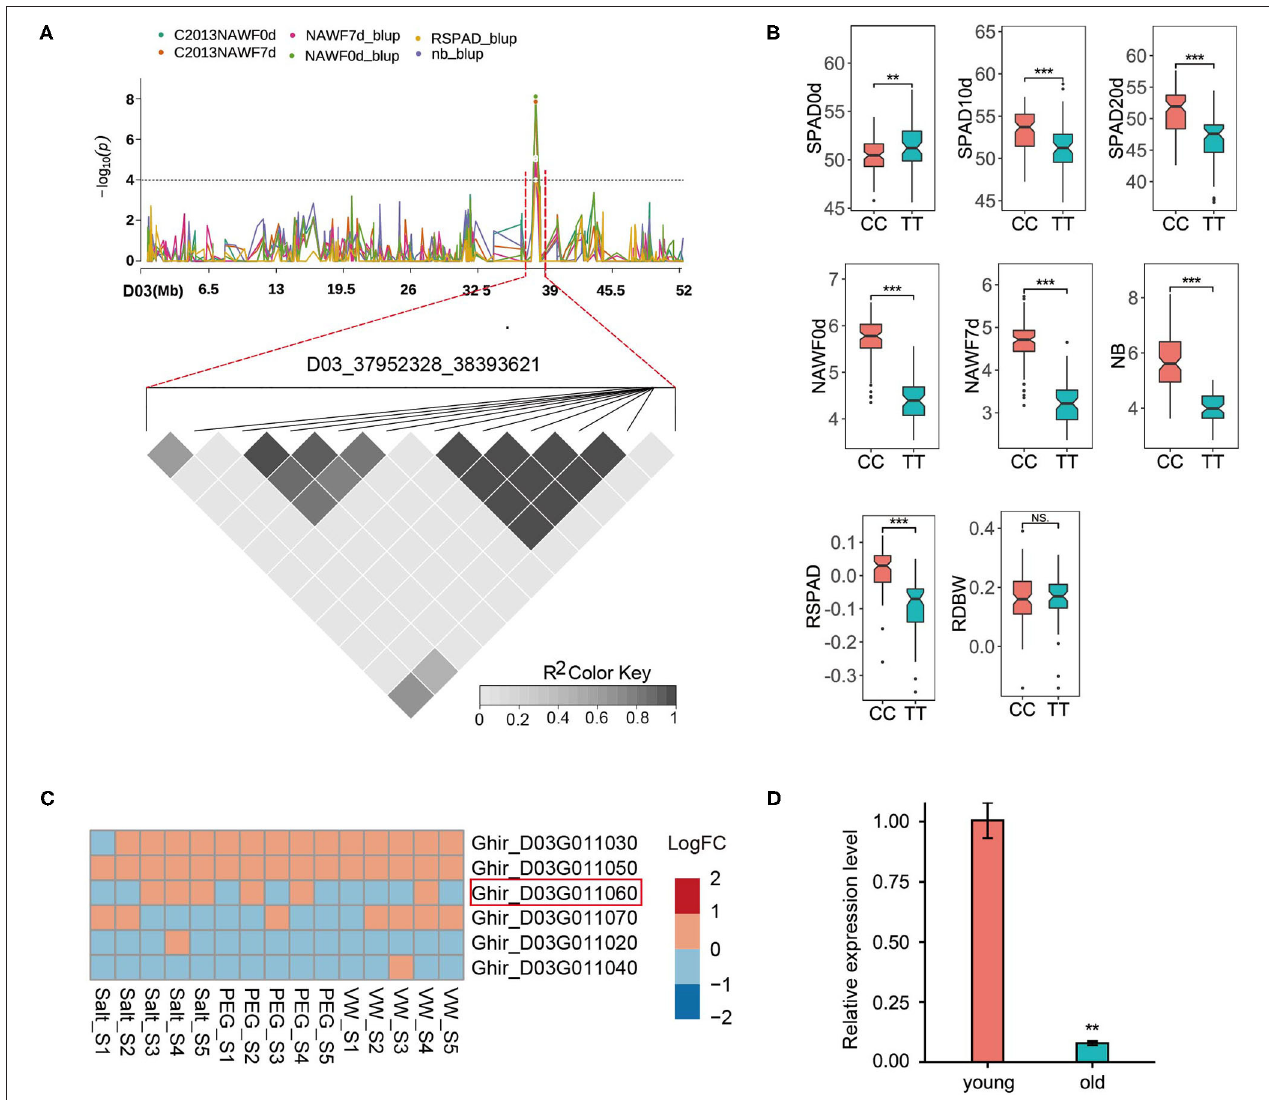
FIGURE 4 | GWAS for senescence-related traits and identification of the candidate genes on chromosome D03. (A) Manhattan plot of multi-traits (top) and LD heat map (bottom) of the genomic risk locus D03_37952328_38393621. (B) Box plots for eight senescence-related traits based on the genotypes of the SNP Ghir_D03_37952328. 61 accessions for the TT allele and 93 accessions for the CC allele. (C) Heatmap of the expression patterns of six predicted genes using the RNA-seq data. Red indicates up-regulated expression, and blue indicates down-regulated expression. S1 - S5: 6, 12, 24, 48, and 72 h after the corresponding treatment. (D) Expression of Ghir_D03G011060 in young and old leaves by qRT-PCR. Asterisks indicate significance levels (*** P < 0.001, ** P < 0.01, and * P < 0.05), NS, not